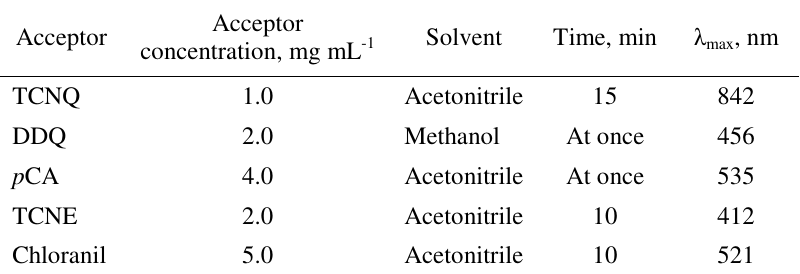
Table 1 . Optimum conditions for the charge-transfer interaction of pregabalin with different